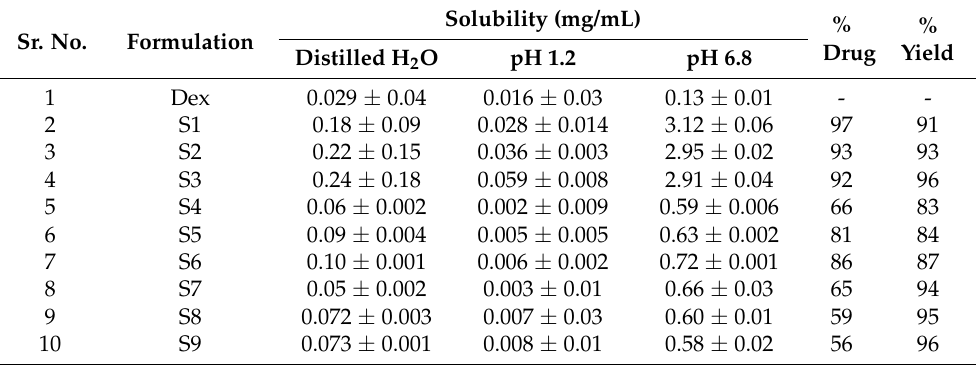
Table 4. Solubility, percentage drug, and percentage yield of binary formulations. Sr.